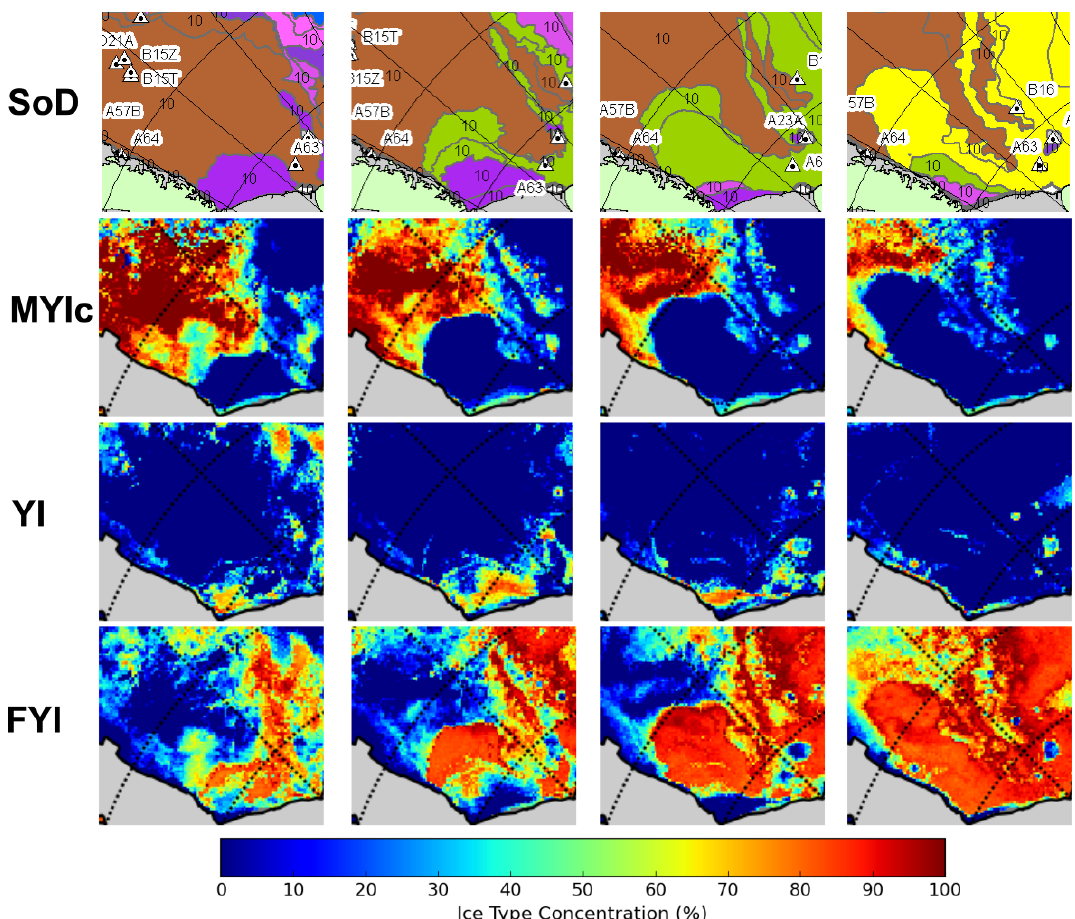
Figure 6. Southwestern Weddell Sea, March to July 2017; top to bottom: SoD charts from AARI, corrected MYI (MYIc), YI, FYI concen- trations; left to right: 16 March, 27 April, 25 May, 6 July 2017.